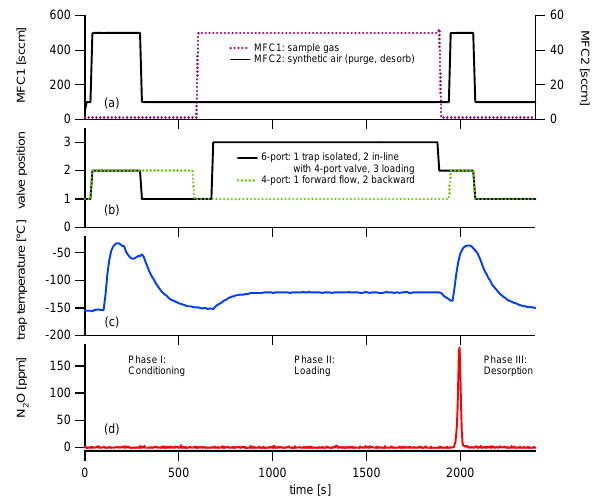
Redy Smart Series, V¨ogtlin Instruments, Switzerland) and the complete preconcentration unit is controlled and moni- tored by LabVIEW (National Instruments Corp., USA).